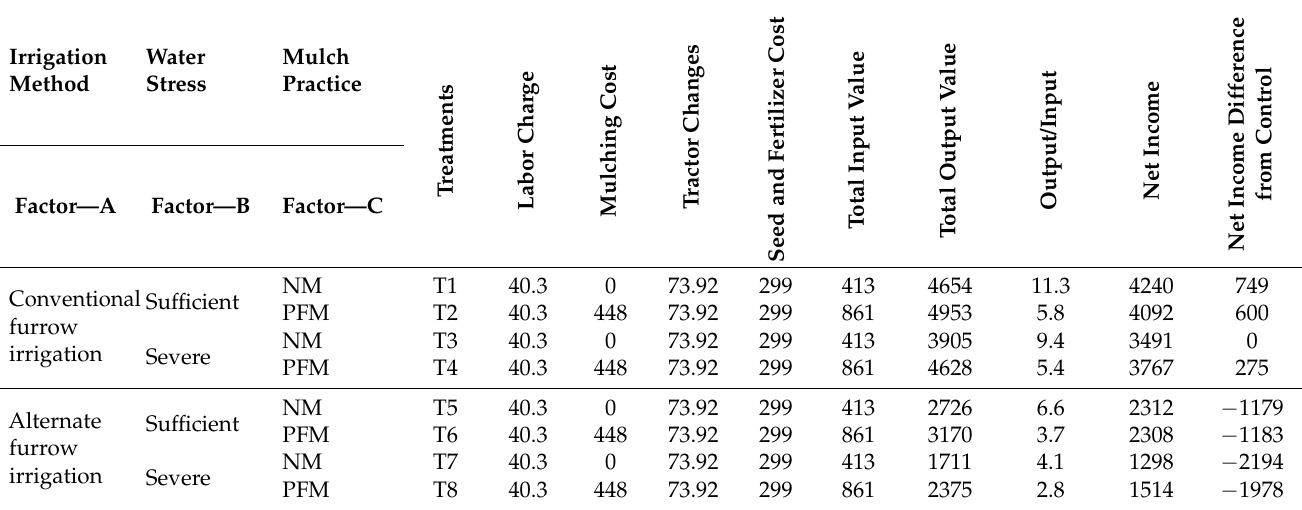
Table 8. Mean economic benefits (USD ha − 1 ) of maize production under different treatments (furrow irrigation method, water stress, and plastic